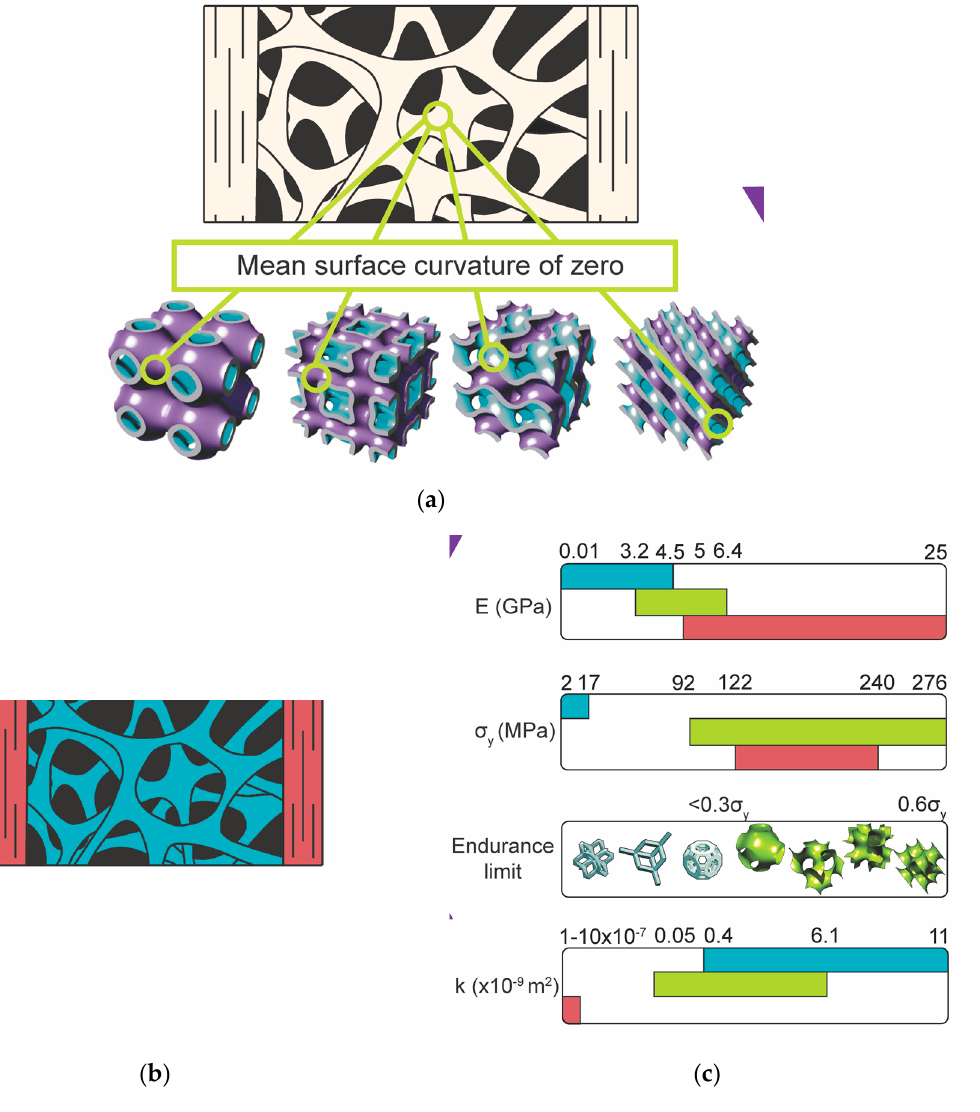
Figure 4. AM meta-biomaterials ( a ) based on triply periodic minimal surfaces that simultaneously mimic different types of bone ( b ) properties including topological, mechanical, and mass transport properties. They also show extremely long fatigue lives. The properties of these meta-biomaterials (light green) are compared with those of cortical (red) and trabecular (cyan) bone ( c ) (Researchers at TU Delft: Françoise Bobbert and Mohammad Ahmadi) (Reprinted from [75] with permission from Elsevier).